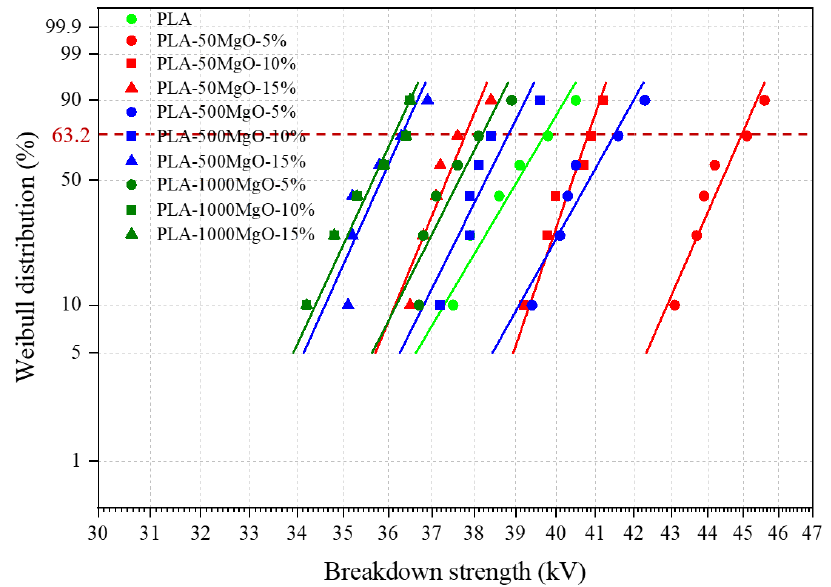
Figure 6. Weibull distribution of breakdown strength.